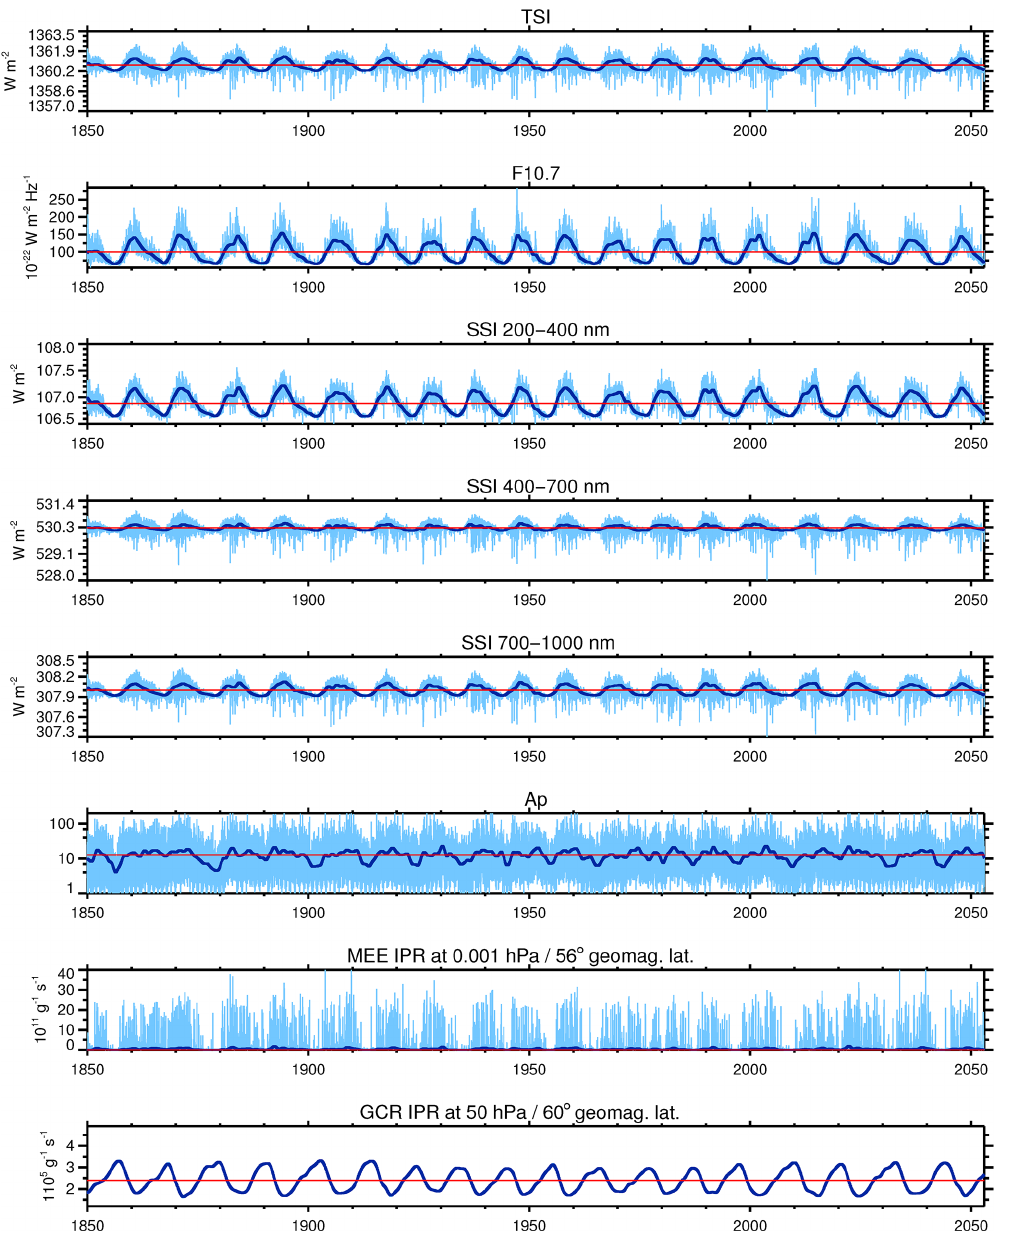
Figure 26. CMIP6 variable (light blue) and constant PI control (red) forcing shown for (from top to bottom) TSI, F10.7, SSI at 200– 400nm, SSI at 400–700nm, SSI at 700–1000nm, Ap, MEE IPR at 0.001hPa and 56 ◦ geomagnetic latitude, and GCR IPR 50hPa and 60 ◦ geomagnetic latitude. Annually smoothed values are shown by dark blue lines. Note the different scale for F10.7 in comparison with Figs. 24 and